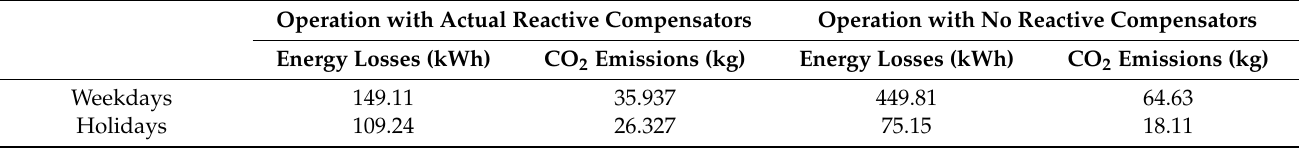
Table 5. Annual energy losses and CO 2 emissions caused by reactive currents in the transformer operation.